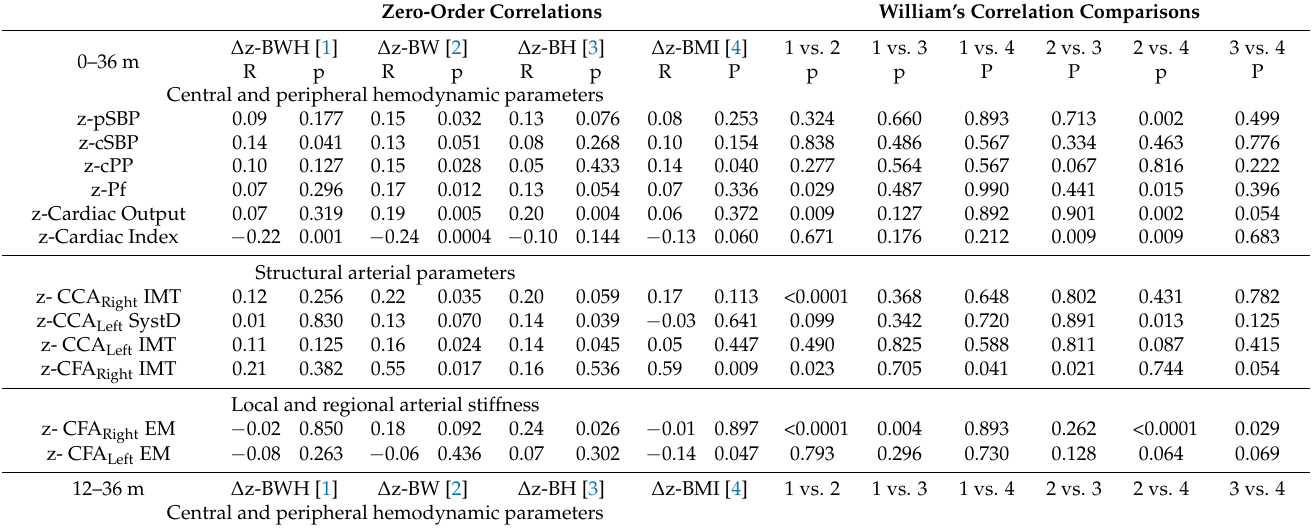
Table 5. Comparison of correlations between arterial z-scores at age 6 years and anthropometric variations in different growth periods (0–36, 12–36, 24–36